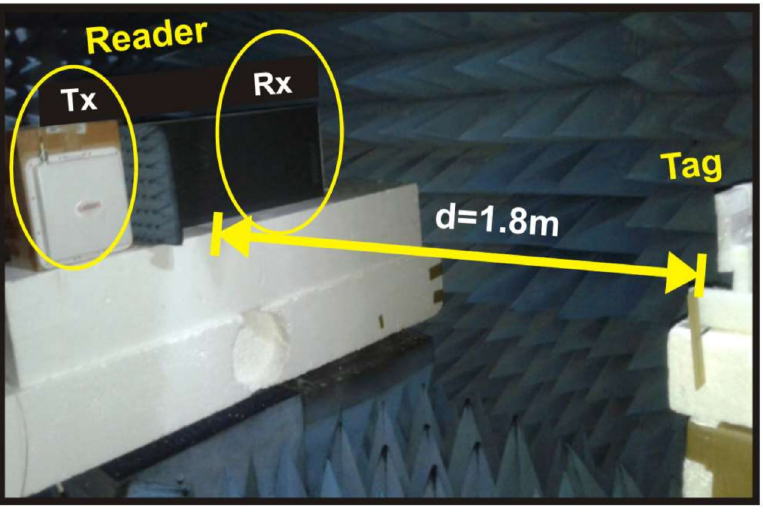
Figure 9. Photograph of the 1 × 2 × 1 system displacement in the NTUST anechoic